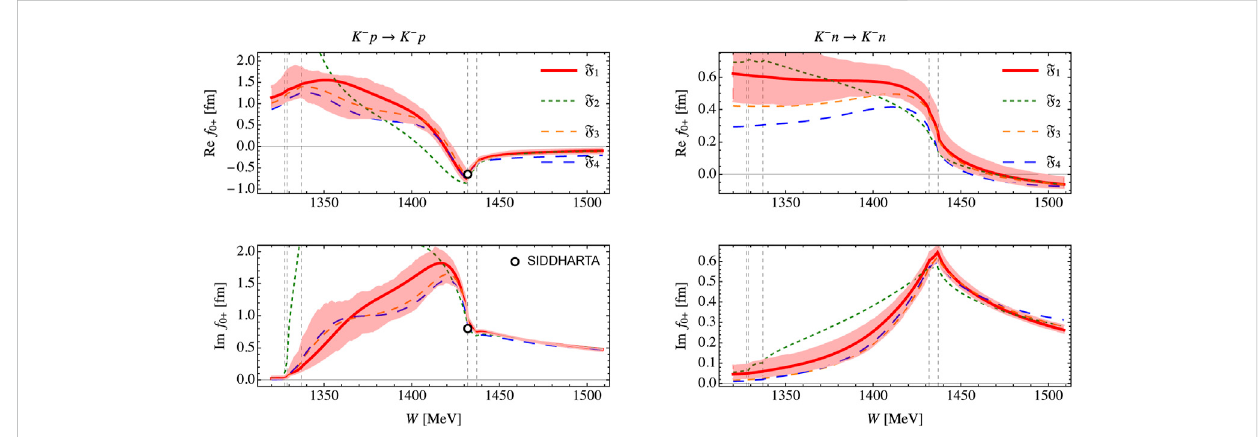
FIGURE 1 Scattering amplitudes for physical channels. Here, the K − n → K − n amplitude is determined assuming isospin invariance. Vertical dashed lines represent the positions of the relevant two-body